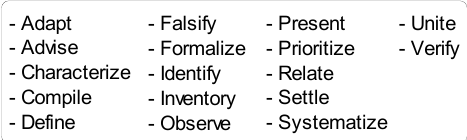
Figure 6. Repertoire of EM